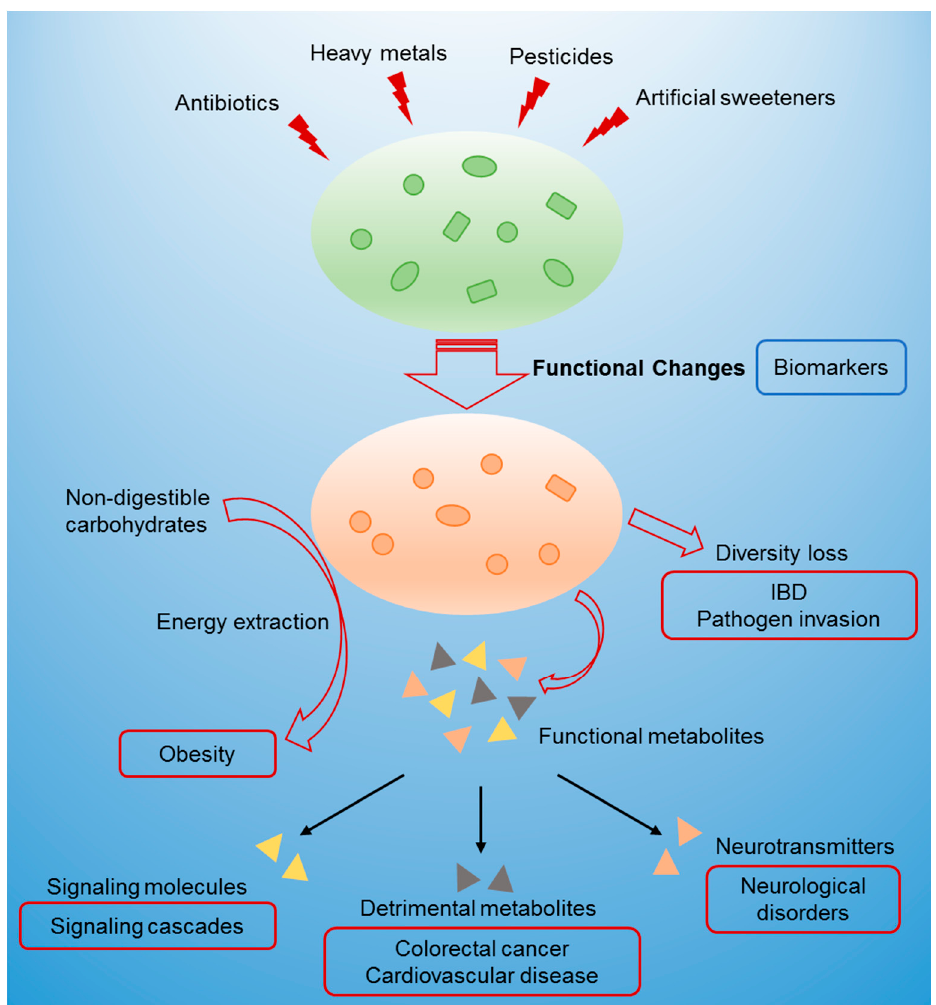
Figure 2. Schematic representation of how gut microbiome toxicity connects the environment and microbiota-associated diseases. Triangles of different colors at the bottom represent functional metabolites produced by a perturbed gut microbiome such as signaling molecules, detrimental metabolites, and neurotransmitters, which could potentially contribute to adverse health outcomes.